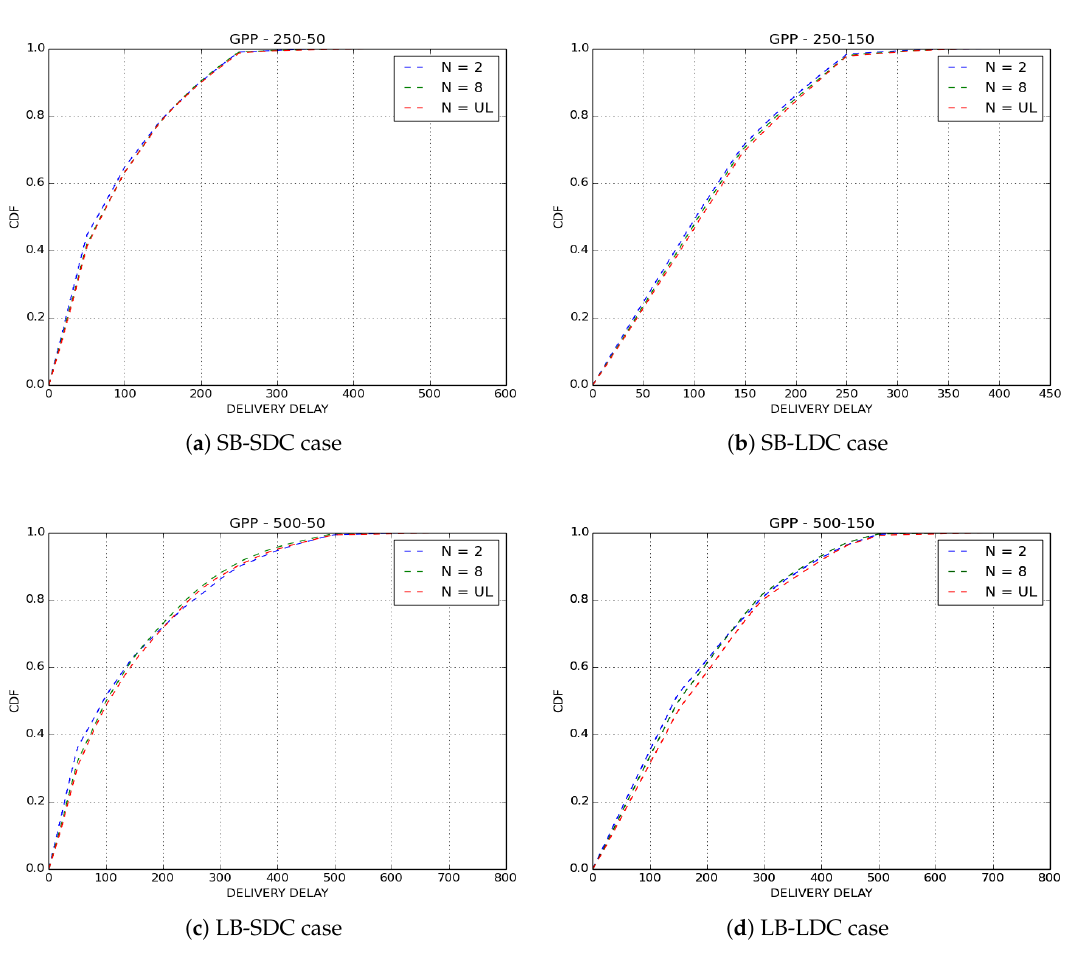
Figure 11. Delivery delay for GPP buffer management